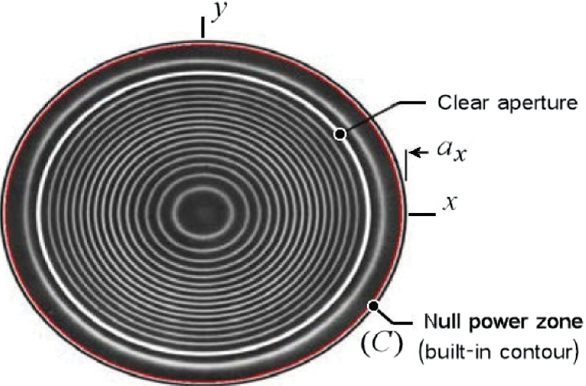
Figure 6: Iso-level lines of a primary mirror M1 generating homothetical ellipses from perfect built-in condition at con- tour C . Elliptic dimensions of the null-power zone over those of clear-aperture must be in a ratio √ 3 / 2 . The algebraic bal- ance of meridian curvatures are then achieved at the center and at the